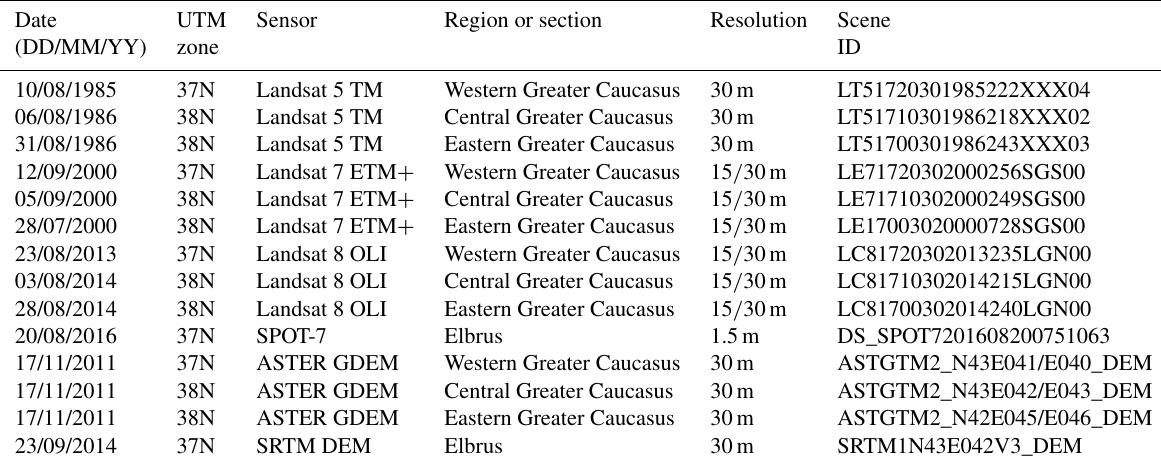
Table 1. Satellite images and digital elevation models used in this